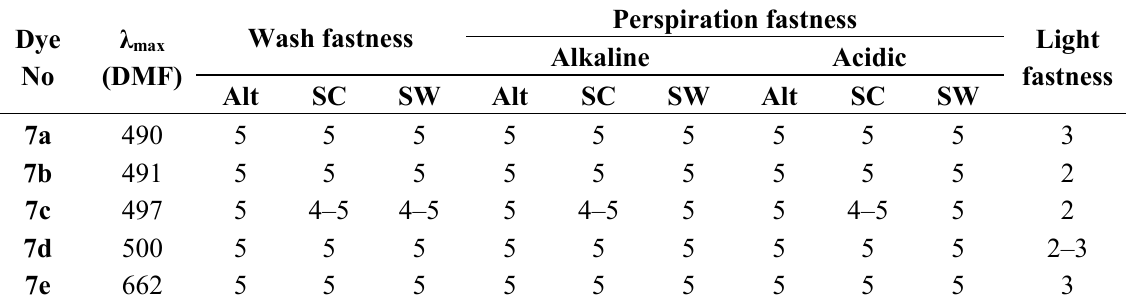
Table 2. Fastness properties of monoazo disperse dyes on polyester fabrics at 2% (o.w.f). Dye Wash fastness